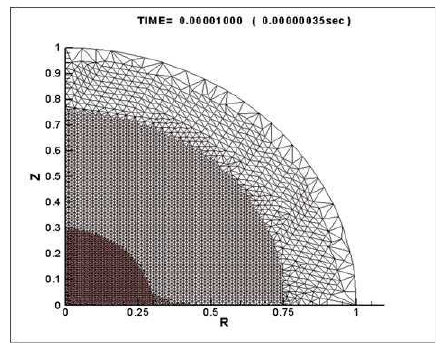
Figure 1: Example of the triangular grid